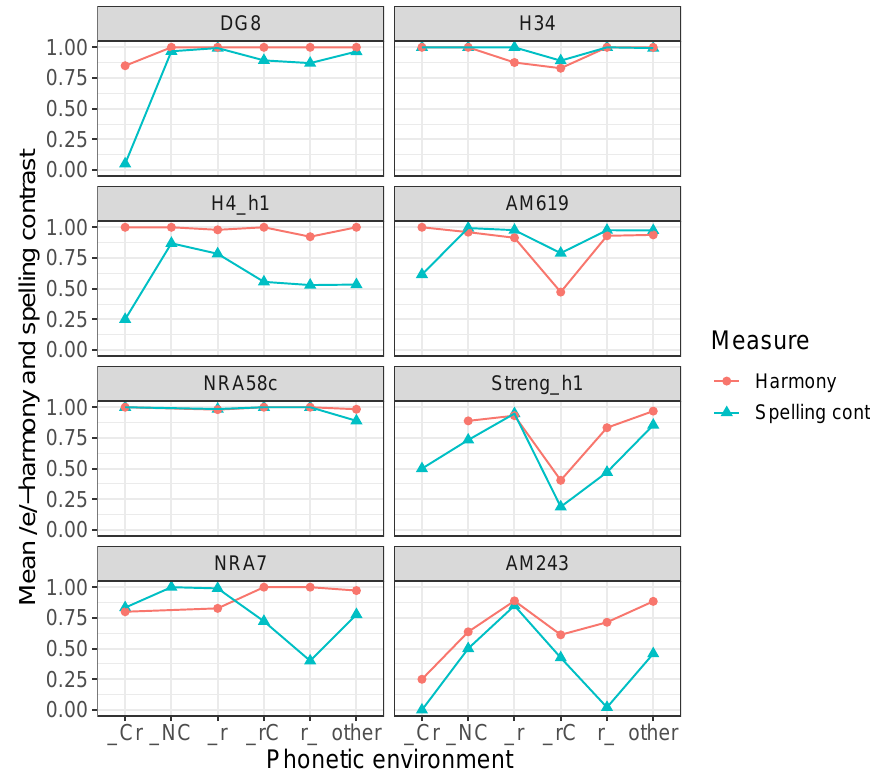
Figure 8: Mean /e/-harmony and spelling contrasts by phonetic environ- ment in /e ɛ/-contrasting